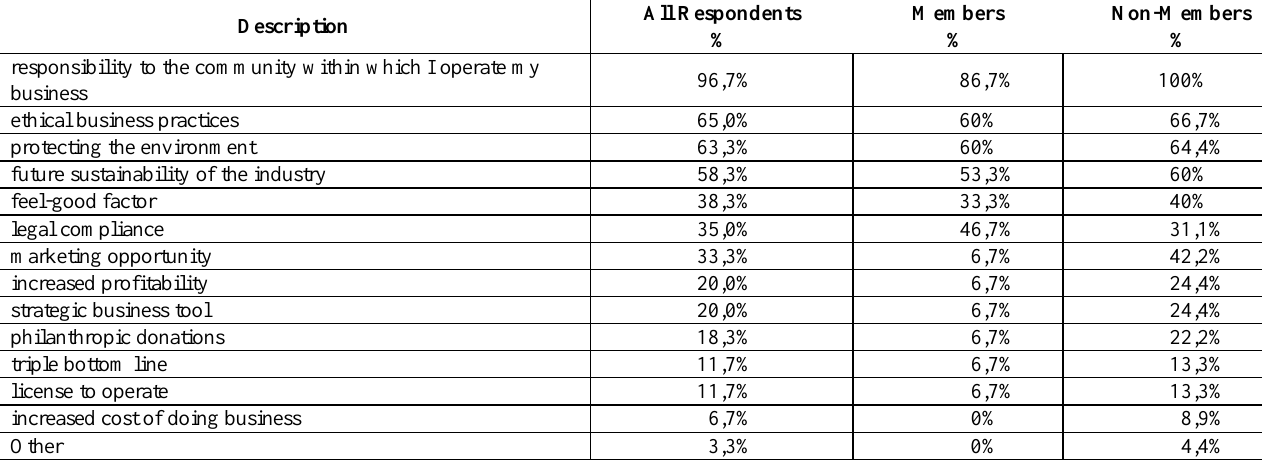
Table 4: Responses to definitions of corporate social responsibility